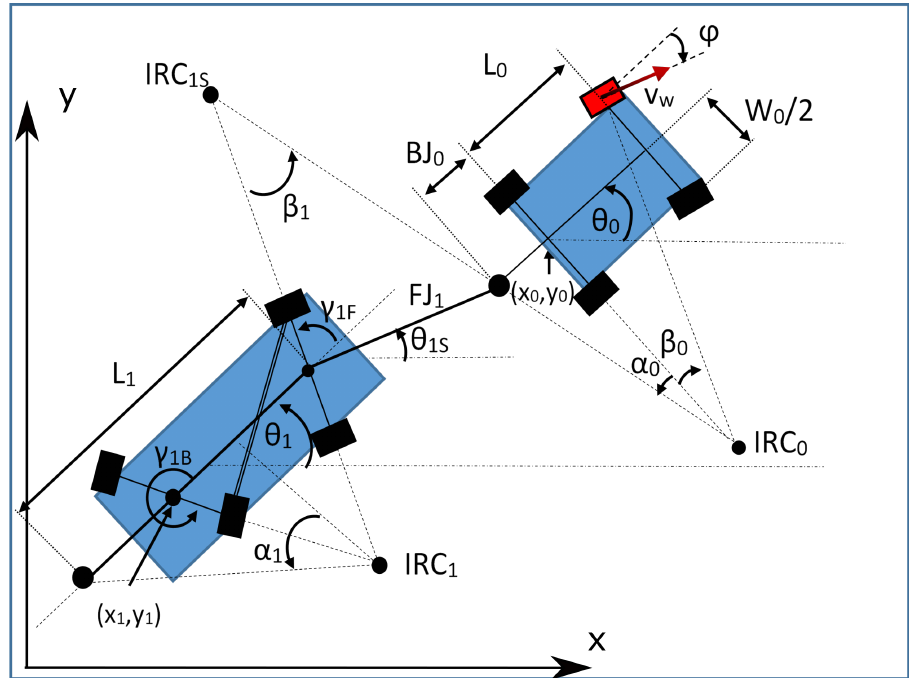
Figure 6. Vehicle with synchronized-shafts